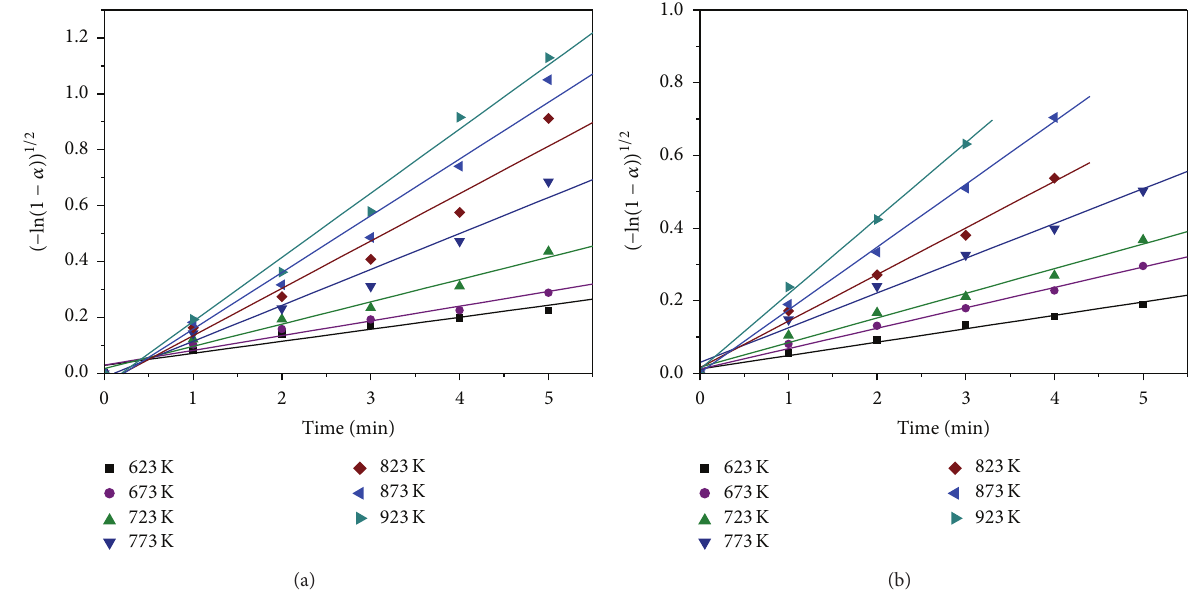
Figure 3: Linear correlation between [− ln (1 − 𝛼)] 1/2 and time for various temperatures: (a) NiO and (b) NiCl 2